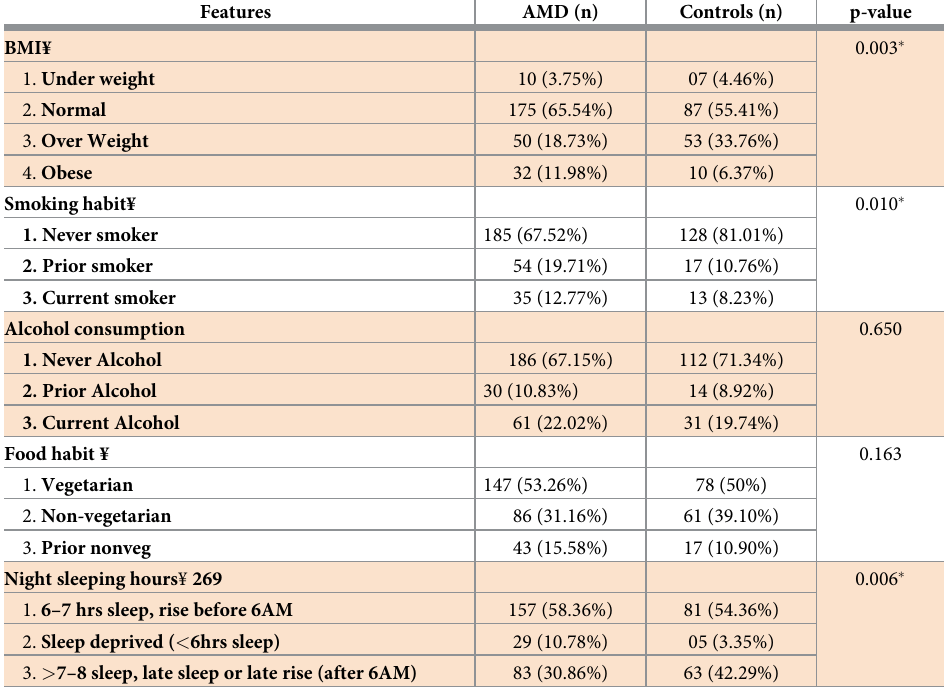
Table 2. Comparative frequencies of activities of daily livings (like BMI, smoking, alcohol consumption, food habit and sleeping pattern) of AMD and control participants.